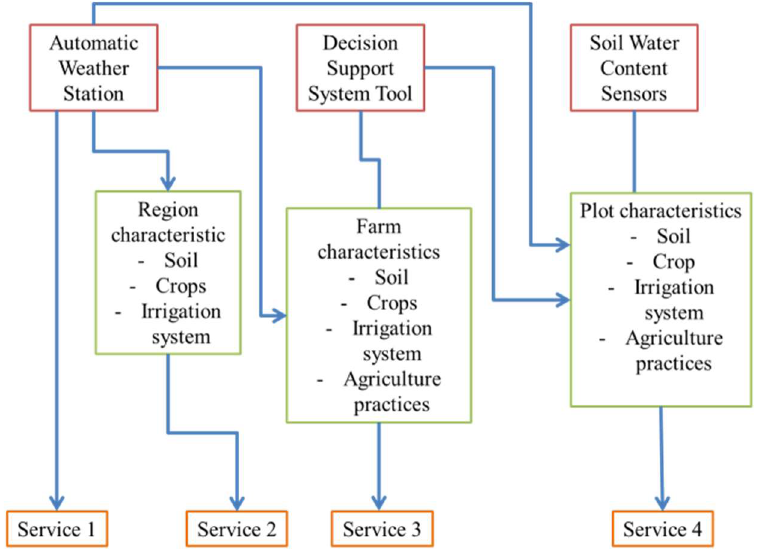
Figure 1. Organization chart of the considered IAS packages, according to